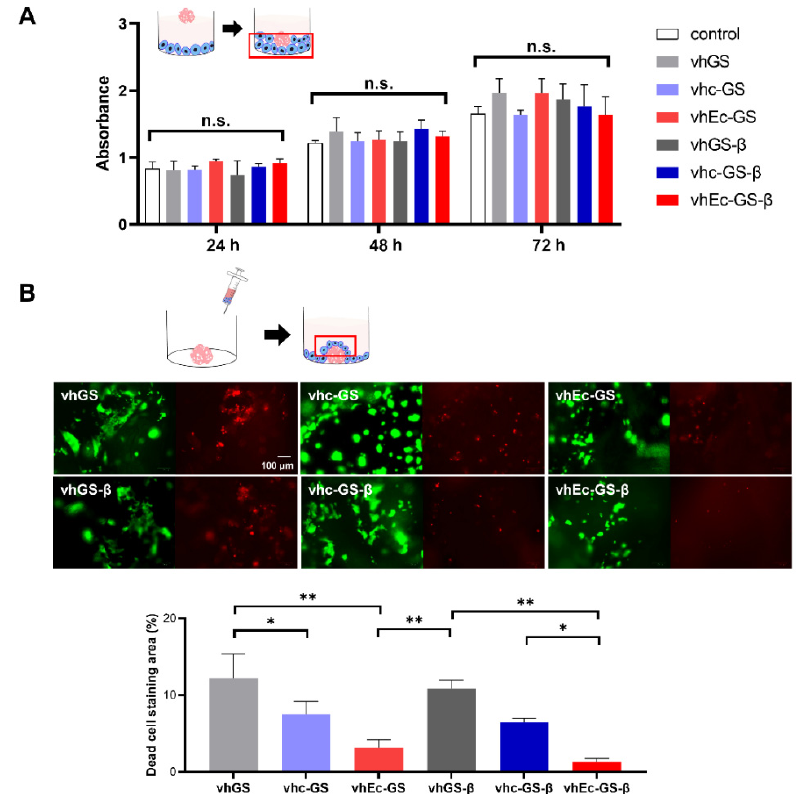
Figure 5. Biocompatibility of hydrogels. ( A ) Cytotoxicity of the hydrogels tested with the CCK-8 assay and osteoblastic cell line UMR106 after 24 to 72 h of incubation ( n = 3). ( B ) Live or dead staining after 24 h of incubation. Green: live cells on the surface of the hydrogels; red: dead cells ( n = 3). n.s.: not significant. * p < 0.05, ** p <